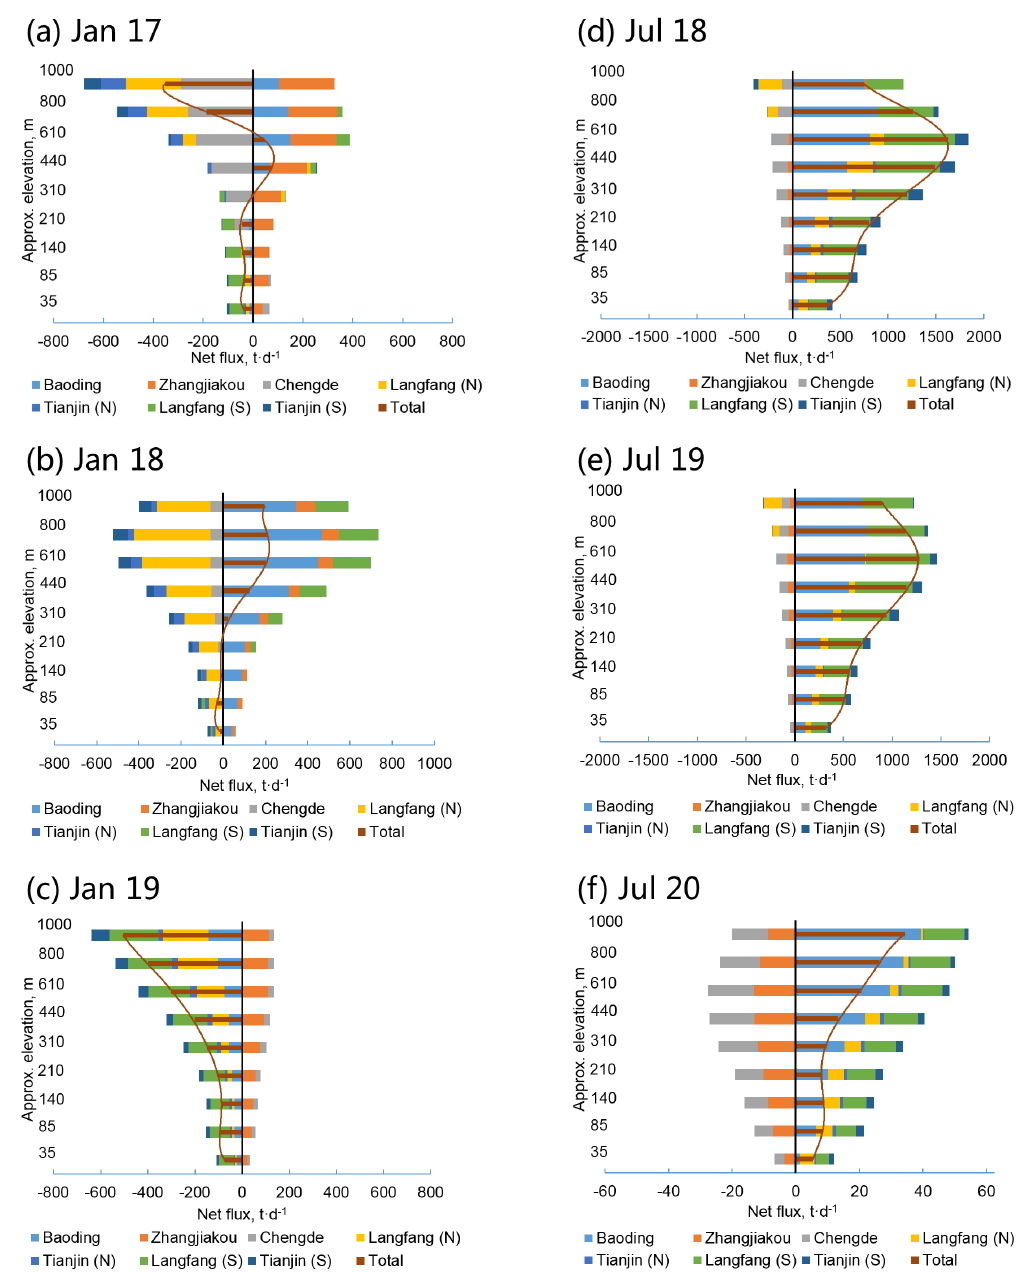
Figure 9. PM 2 . 5 fluxes during heavy pollution days in Beijing in January and July: (a) 17 January, (b) 18 January, (c) 19 January, (d) 18 July, (e) 19 July and (f) 20